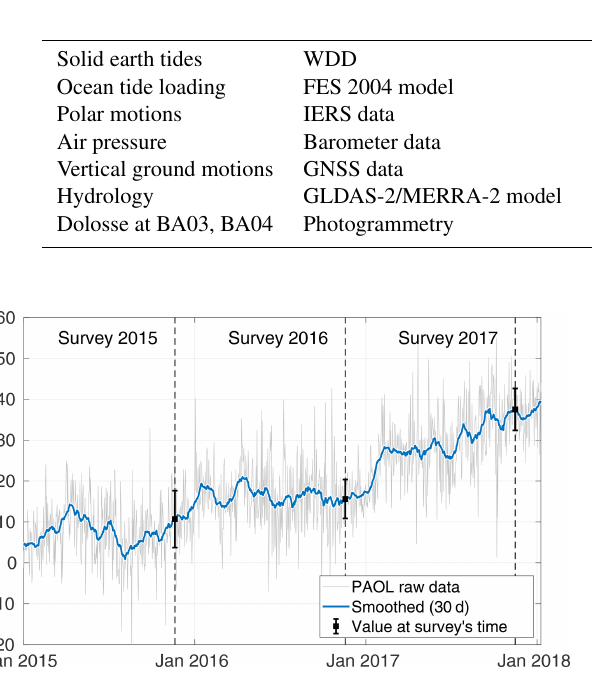
Figure 4. Ground vertical displacement time series at the PAOL GNSS station, colocated with AG06, provided by the GPSLAB database (IES-AS, 2015). Solutions are computed in the IGS08 reference frame (Rebischung et al., 2012). The time of each joint gravimetry–photogrammetry survey is shown by dotted lines. The error bar is computed from the SD of the measurements of the same 30d